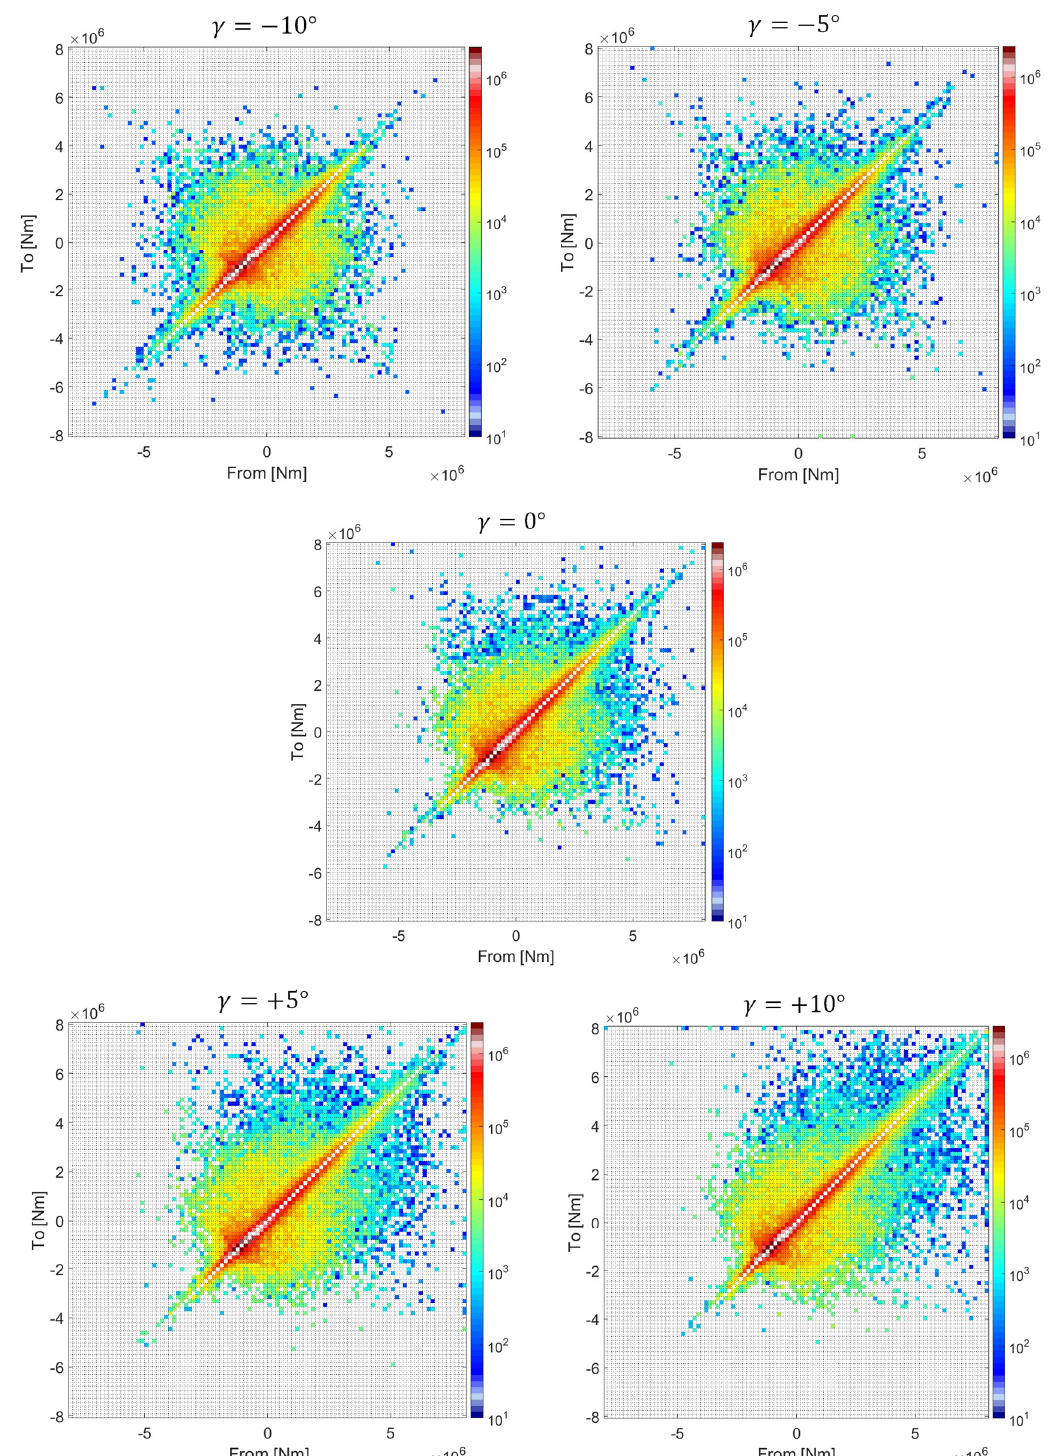
Figure 4. Rain flow count of the tilt moment (around y‐axis) for various nacelle positions and a timespan of 20 years ( top left : −10°; top right : −5°; middle : 0°; bottom left : 5°; bottom right : 10°).